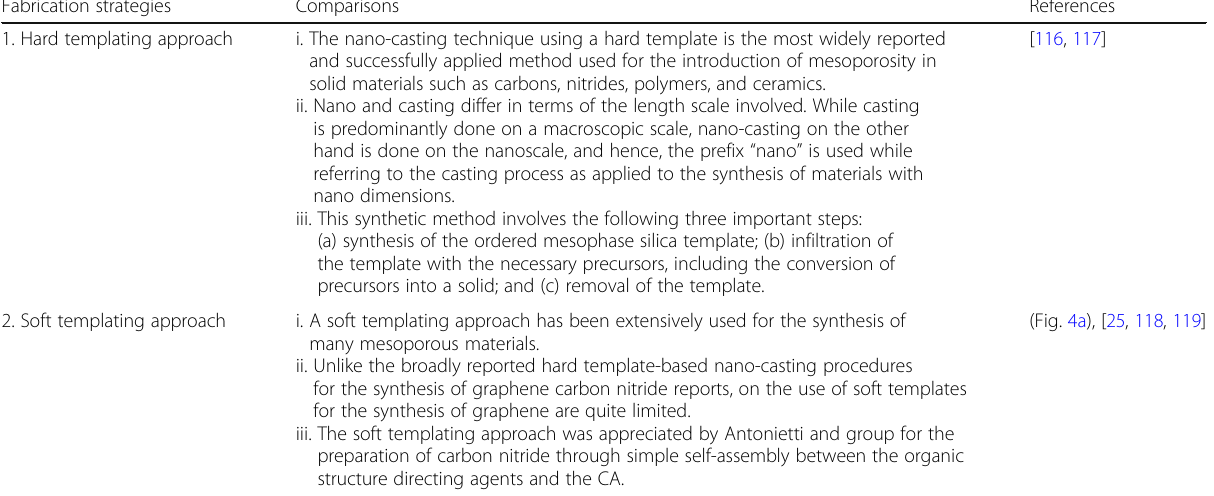
Table 1 Comparisons between hard templating and soft templating approaches used for g-C 3 N 4 synthesis Fabrication